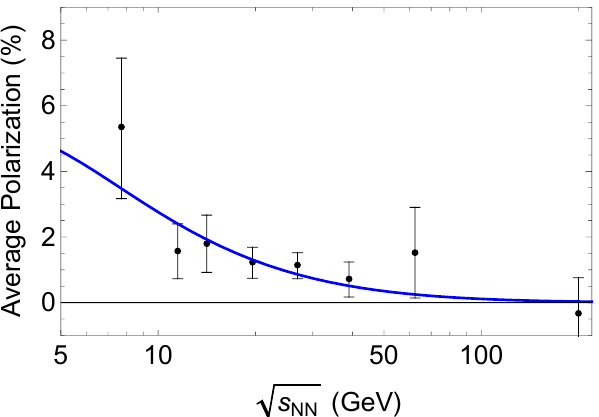
Figure 1: A comparison of our estimate (32) of the average hyperon polarization (blue) to the STAR measurement [ 1 ] . Since a magnetic field was not incorporated in our setting, we have compared our estimate to the average value of the polarization of Λ and Λ